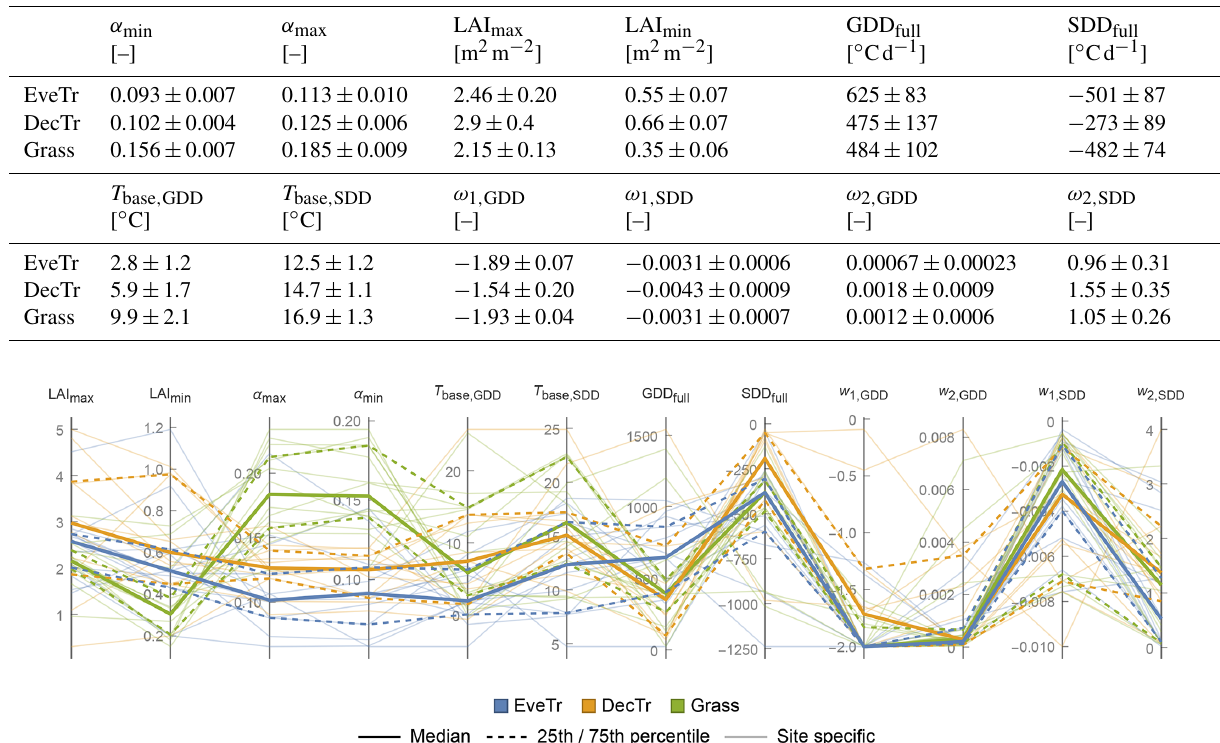
Figure 5. Variation in LAI-related parameters (12 labelled vertical lines, Sect. 2.2.1) within three land cover classes (colour) showing median (thick line), interquartile range (IQR, 25th and 75th percentiles, dashed lines) and site-specific values (thin